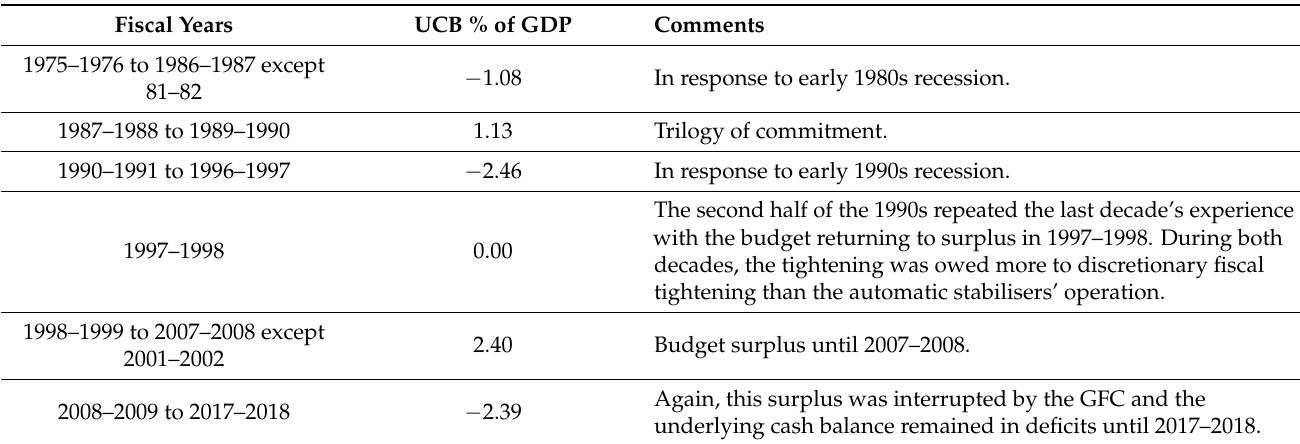
Table A1. Australian Underlying Cash Balance (per cent of